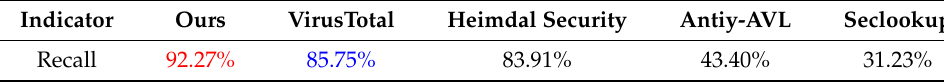
Table 10. Recall rates of different open access detection